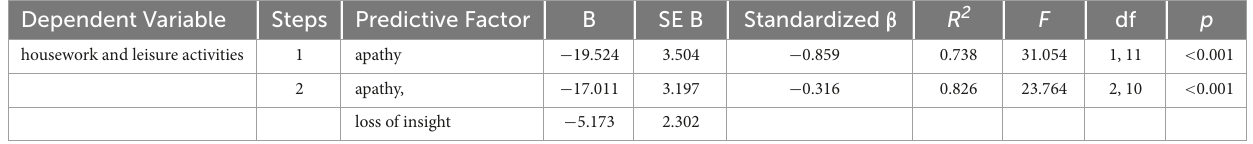
TABLE 4 Summary of the second set of stepwise regression analyses regarding the behavioral symptoms with the greatest contribution to housework and leisure activities, as assessed by the FBI and DAD